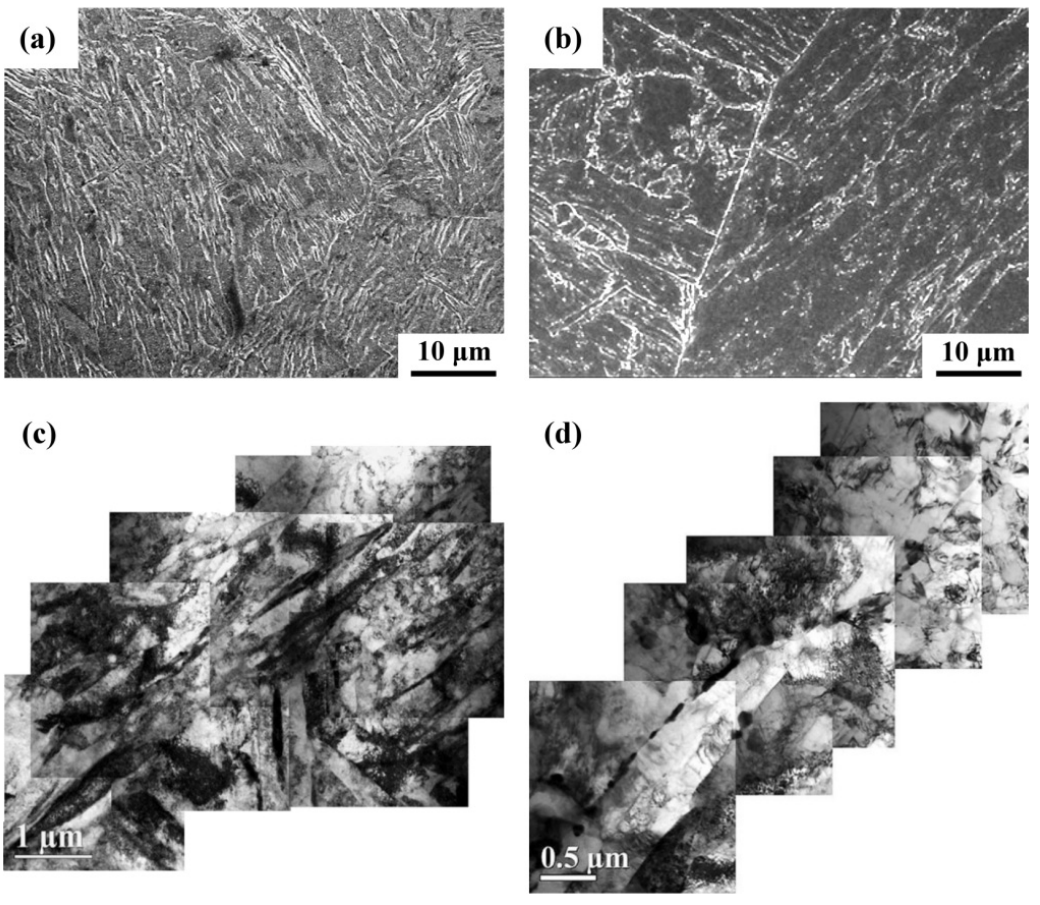
Figure 4. The microstructures of the WM in the as-welded ( a – c ) and tempered ( b – d ) conditions. ( a , b ) scanning electron microscope (SEM) micrographs; ( c , d ) transmission electron microscope (TEM) micrographs.